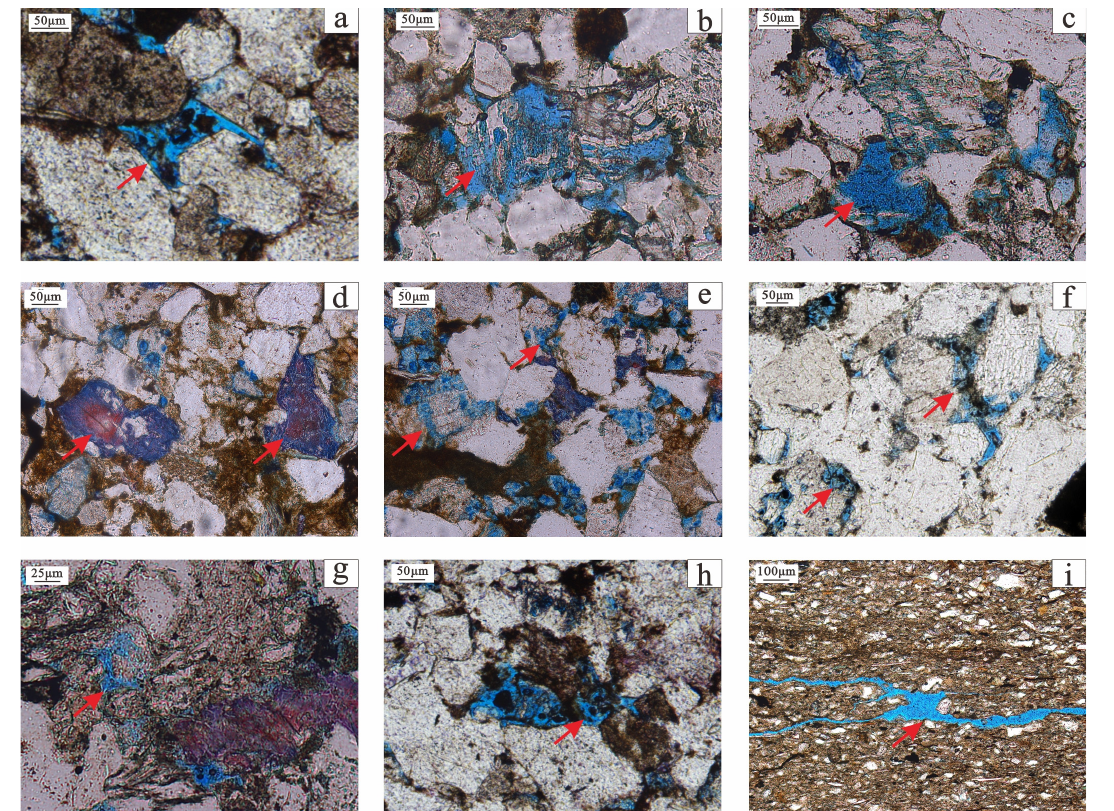
Figure 4. Pore types of the Chang-7 Member in Ordos Basin: ( a ) N229, 1710.14 m, intergranular pores; ( b ) L337, 2284.3 m, feldspar-dissolved pore; ( c ) Z255, 1748.4, melodic pore; ( d ) Z230, 1743.9 m, melodic pore; ( e ) L304, 2489.6 m, intergranular dissolved pore; ( f ) N229, 1710.14 m, intergranular dissolved pore; ( g ) M27, 2745 m, debris solution pore; ( h ) N229, 1737.98 m, debris solution pore; ( i ) L272, 2497.42 m, microcrack.